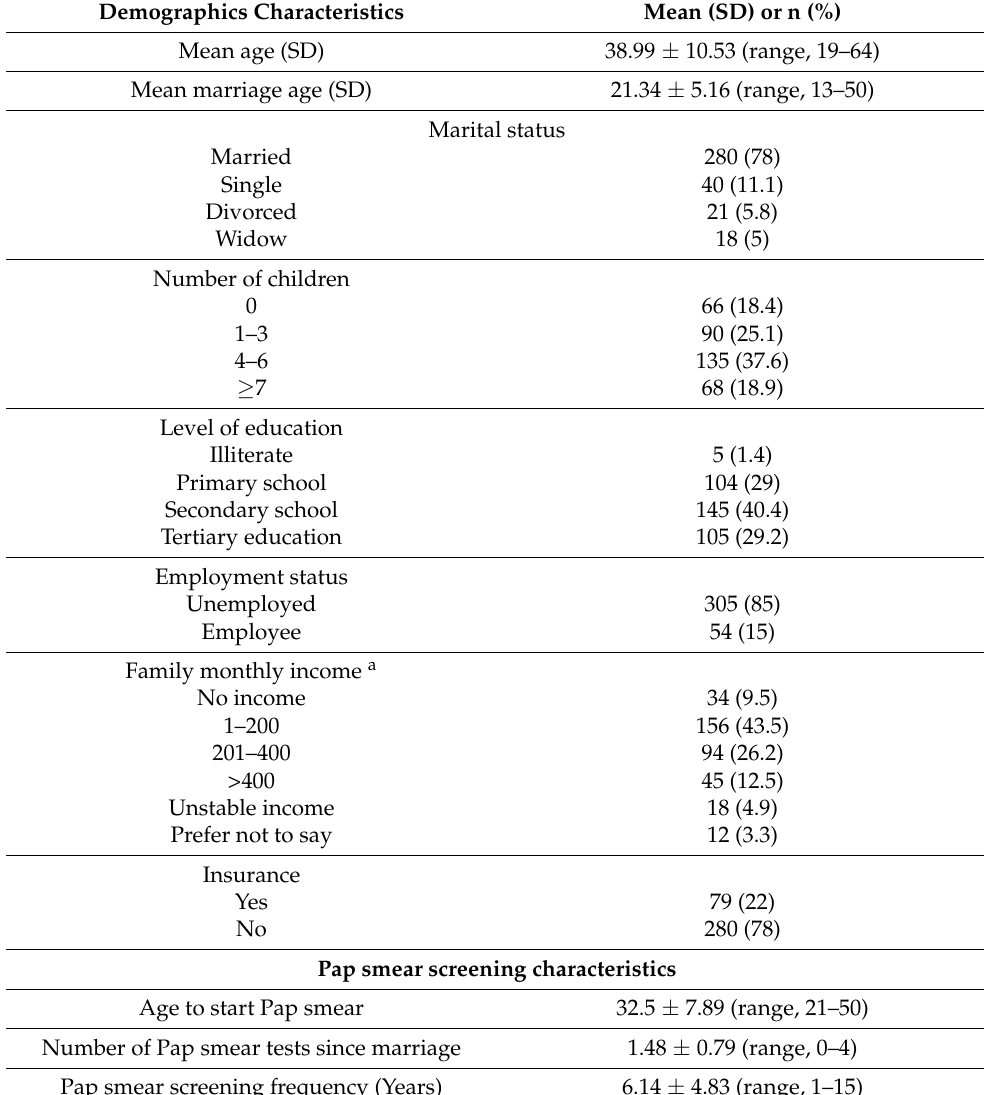
Table 1. Socio-demographics and Pap smear screening characteristic of participants. Demographics